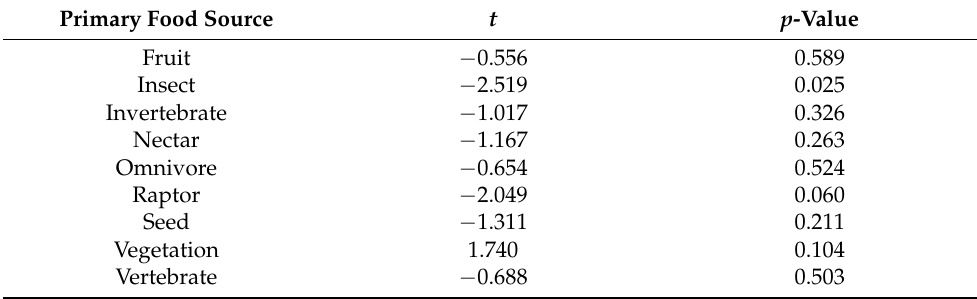
Table 5. Results of paired t -test for difference in the number of bird species by primary food source between 1998 and 2018 in areas where greenspace has decreased (df = 14). Primary Food